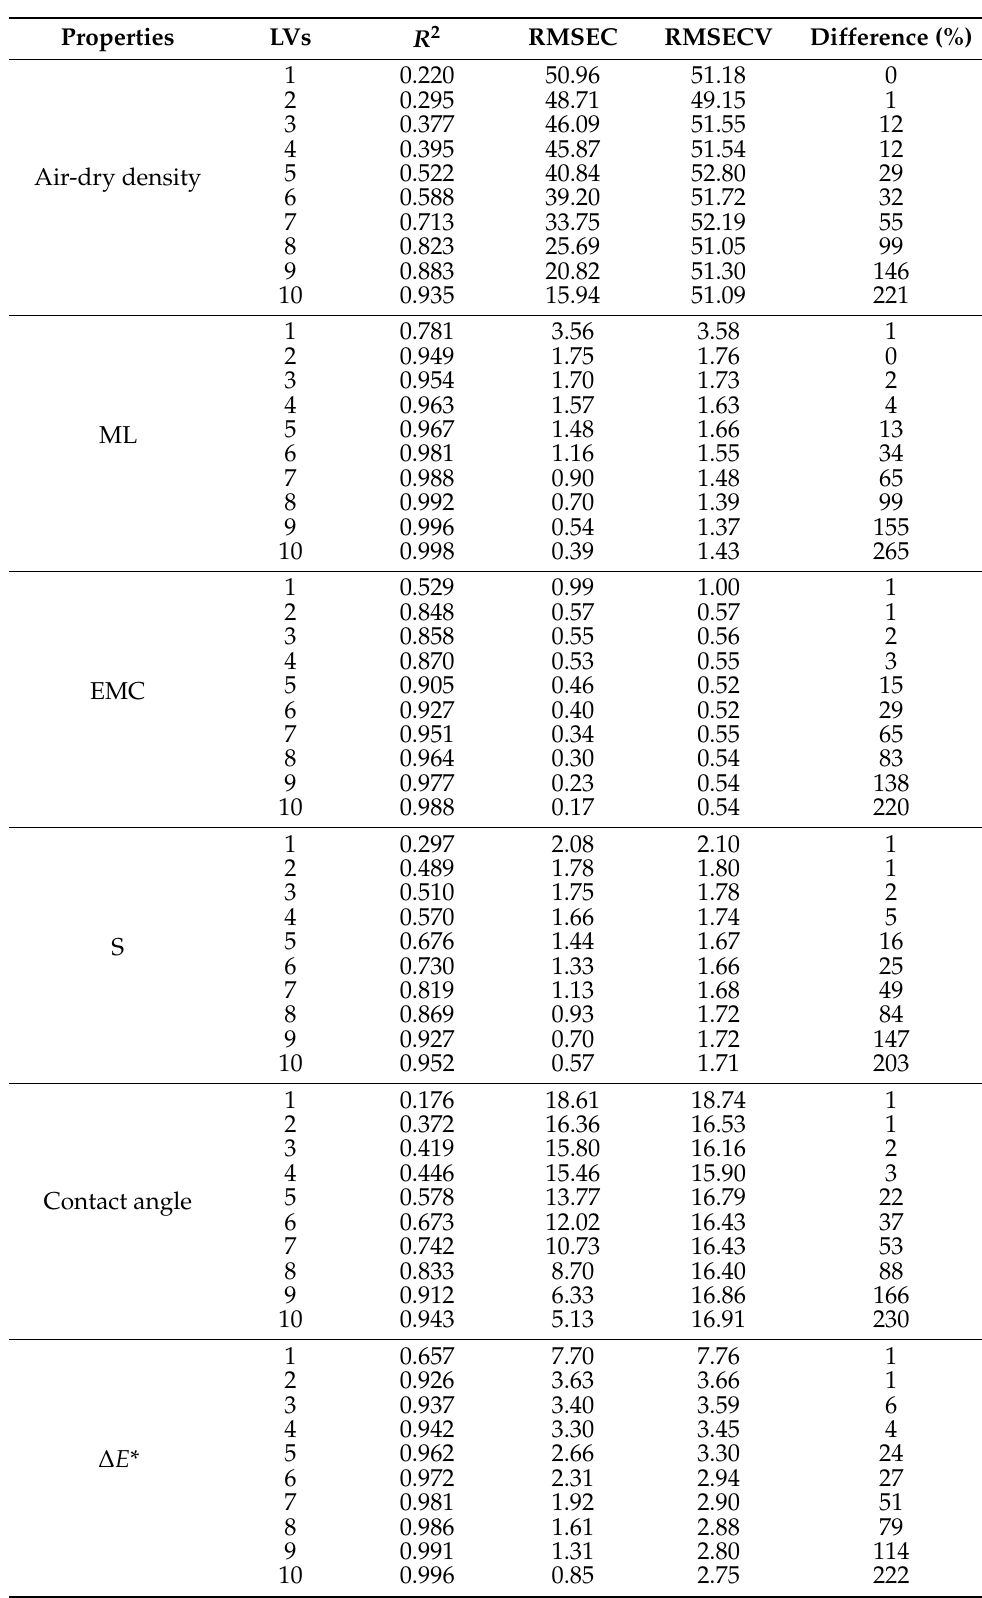
Table 4. Results of PLSR model by different